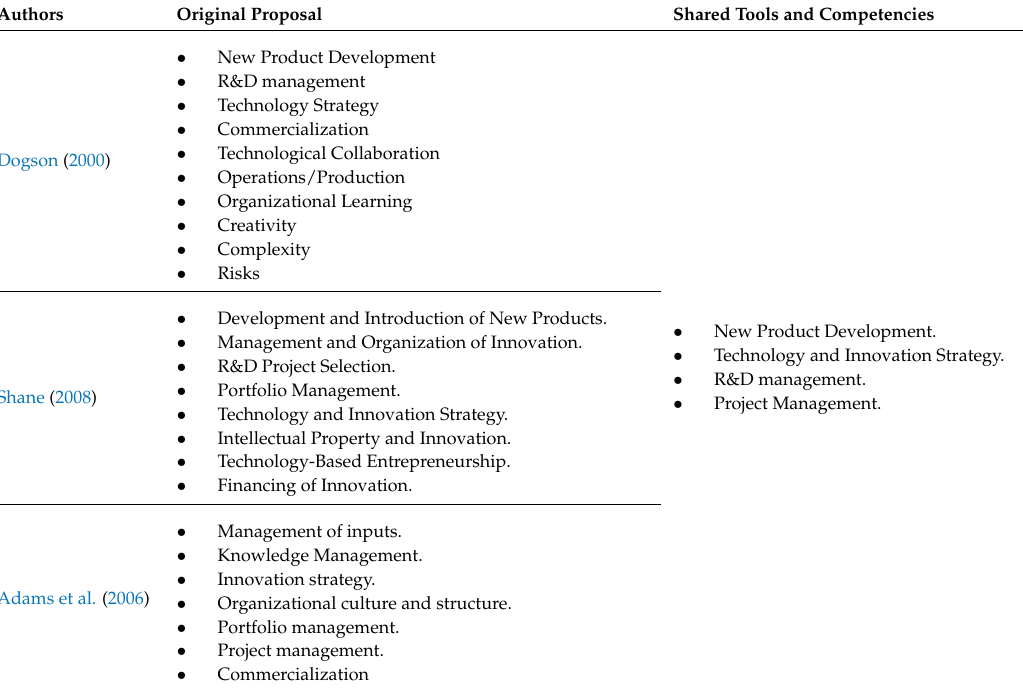
Table 1. Approaches to Technology and Innovation Management. Source: Own